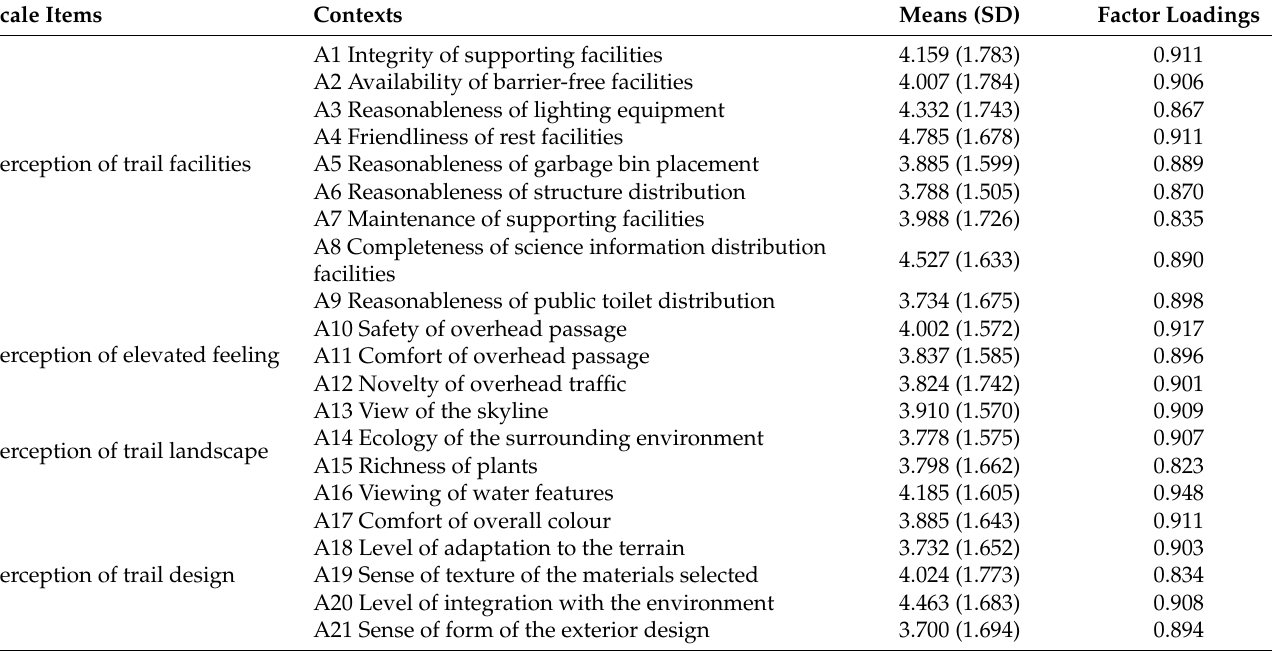
Table 2. Items, reliabilities, and mean and standard